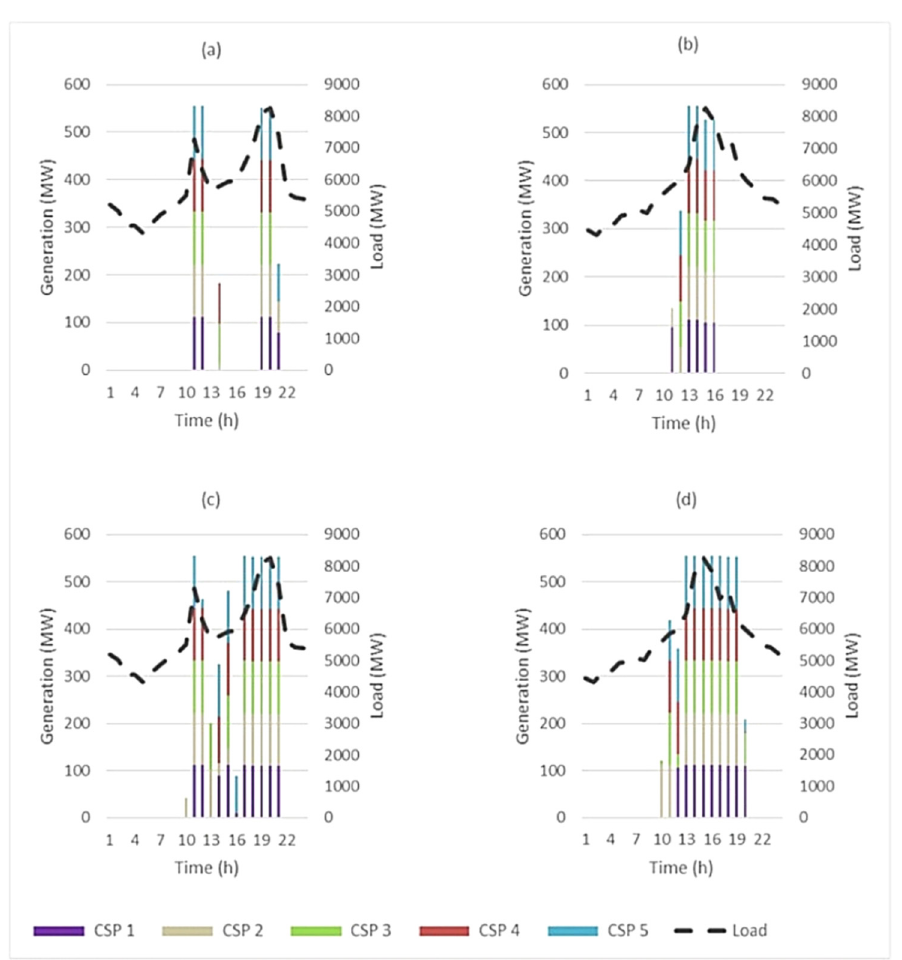
Figure 7. Load and generation of five CSP plants in the hydrothermal system in the following sce- narios: wet/night ( a ), wet/day ( b ), dry/night ( c ), and dry/day ( d ). scenarios: wet/night ( a ), wet/day ( b ), dry/night ( c ), and dry/day ( d